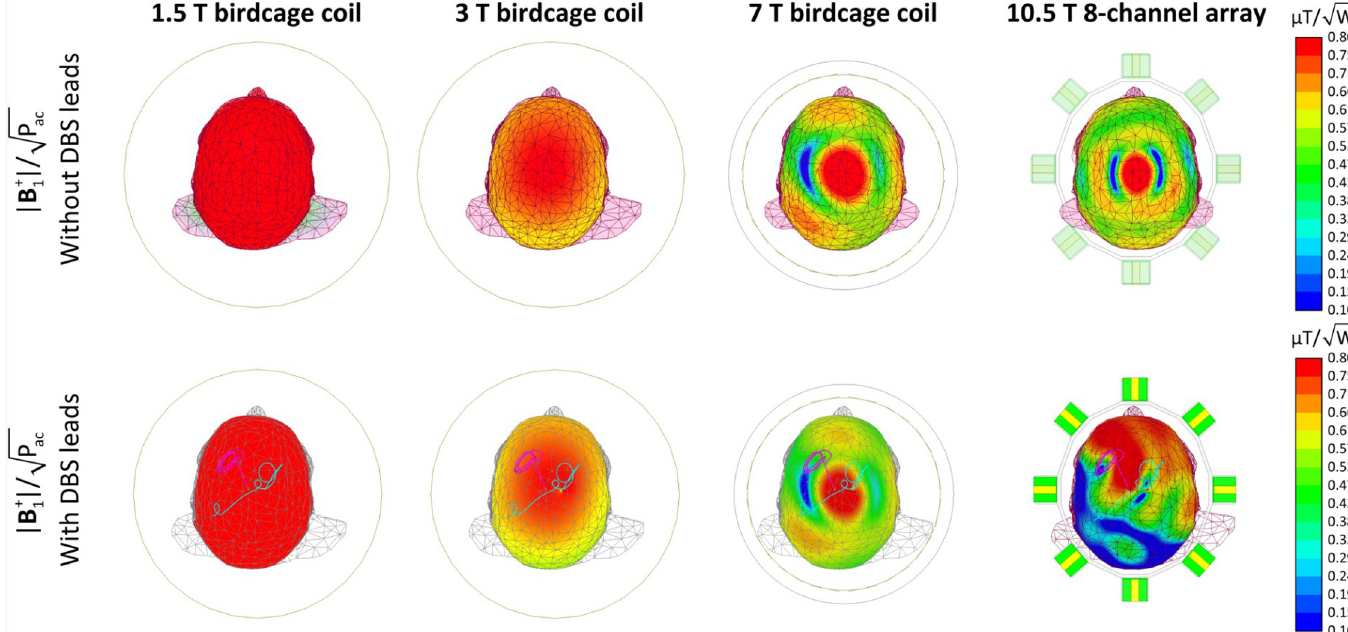
Fig 6. Normalized B 1+ maps of the 1.5 T, 3 T, 7 T and 10.5 T coils on an axial plane passing through the iso-center in human head model with no implants (top rows) and with implants (bottom row). All four coils are driven in the CP excitation mode, where their inputs are adjusted to keep the accepted power (Pac) as 1 W. The B 1+ maps of the second row were acquired for patient 12